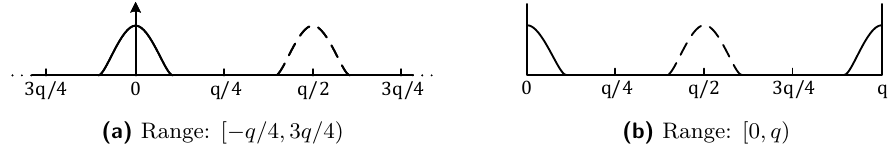
Figure 1: Typical probability distribution of the coefficients of the noise plaintext m 0 . The solid line marks the distribution for a 0 bit, the dashed line for a 1